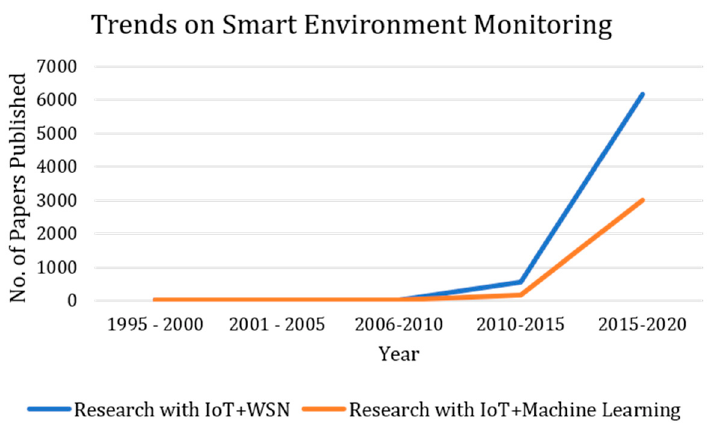
Figure 4. Trends of SEM methods.